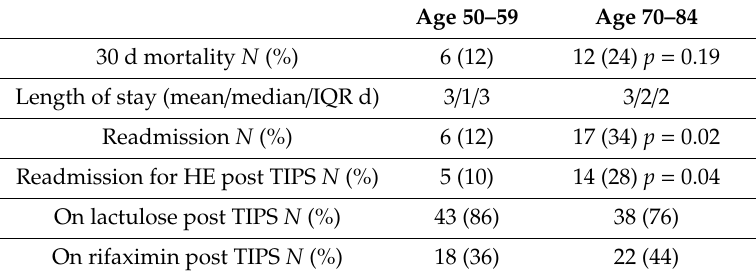
Table 3. Outcomes after TIPS in study